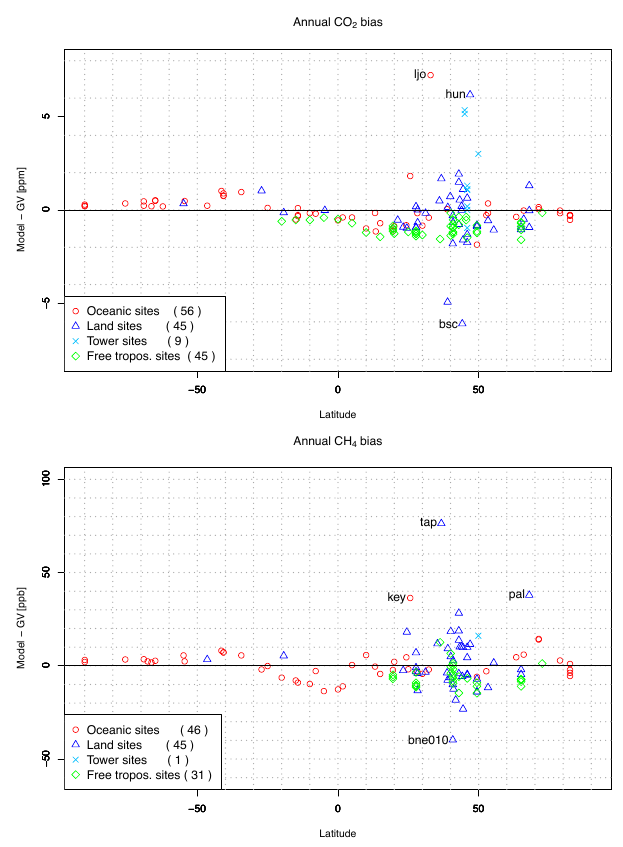
Fig. 3. Latitudinal distributions of differences in annual mean be- tween the simulated and GV data for CO 2 (top) and CH 4 (bottom) at GV monitoring sites for the year 2008. The simulated results at 13:00–16:00LT were used for the comparison. Letters in the plot represent the GV site code. Site types in the legend are the same as those defined in Fig. 2. Numbers in legend parentheses indicate the numbers of GV sites used for the